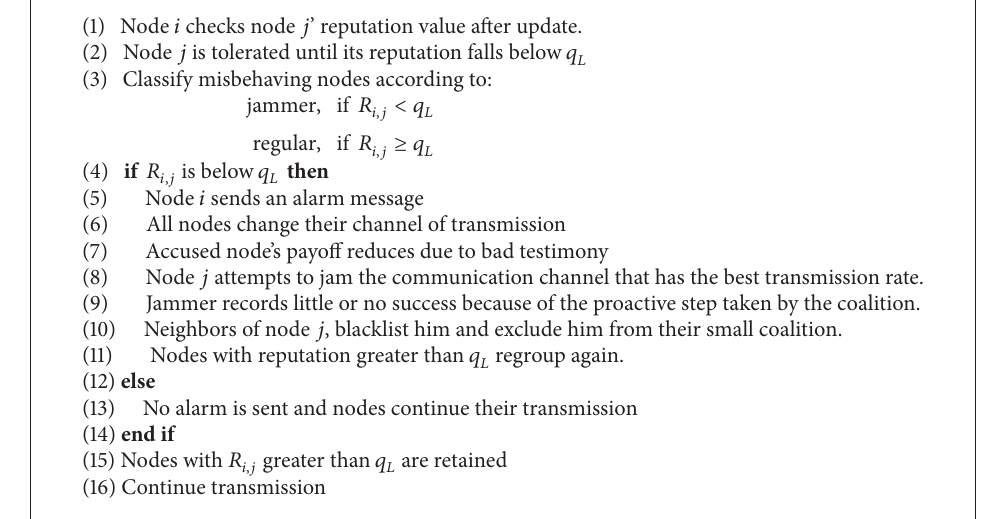
Algorithm 3: Jammer exclusion from the coalition.